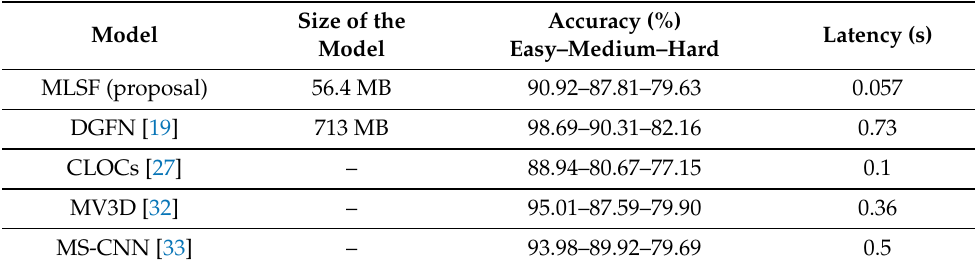
Table 2. Comparison of LiDAR-Camera fusion networks for target